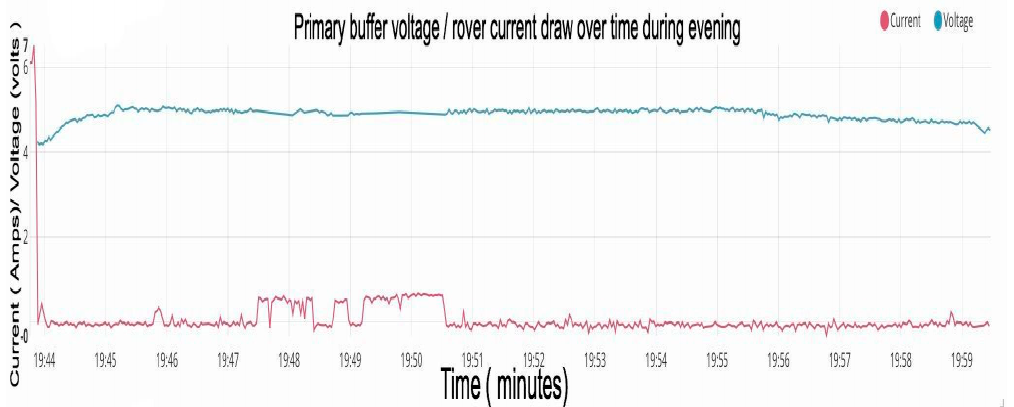
Figure 6. Second test during lower luminous intensity. Voltage dips slightly during current spikes. The voltage increases very slowly during rest periods.